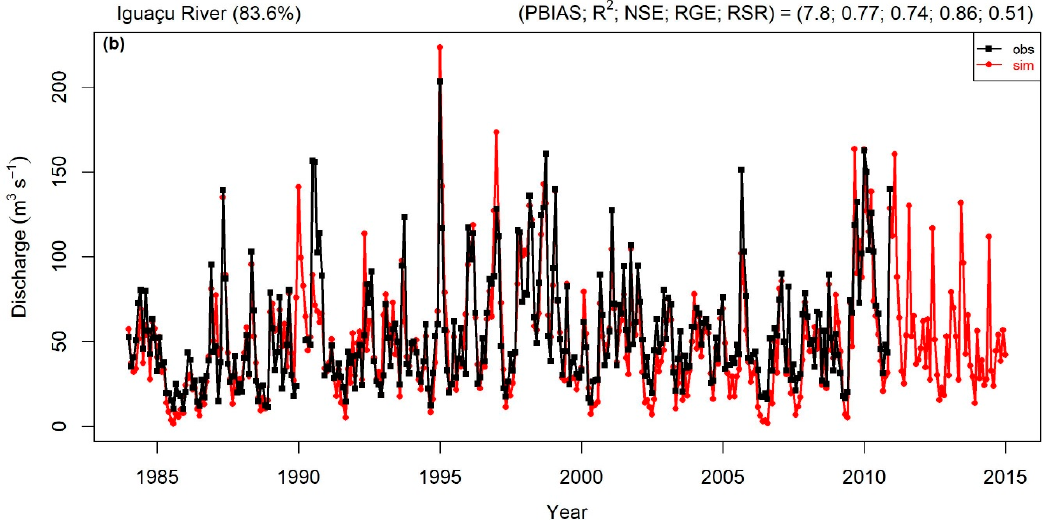
Figure 4. Map showing the sub-basins with and without calibration (on the top), and examples of discharge simulation representing good performance rating.